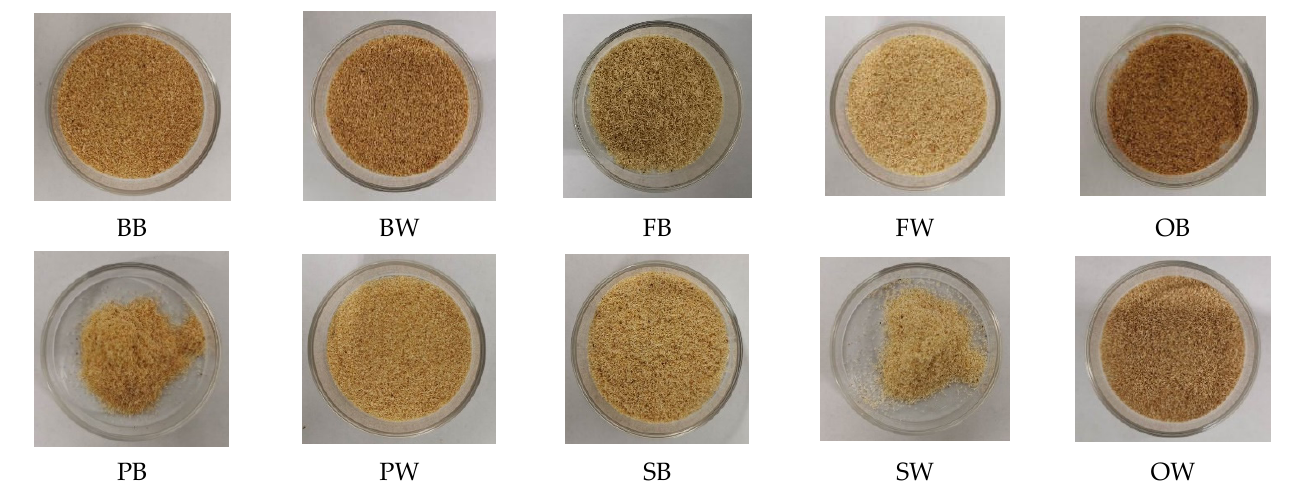
Figure 1. Slovakian wood dust of ten samples employed in this study.